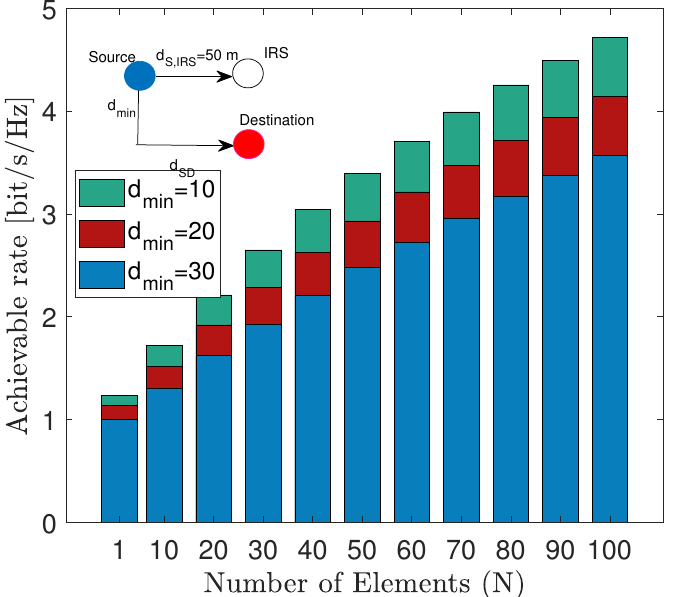
Figure 5. Throughput of IRS against varying number of elements and minimum separation between source and